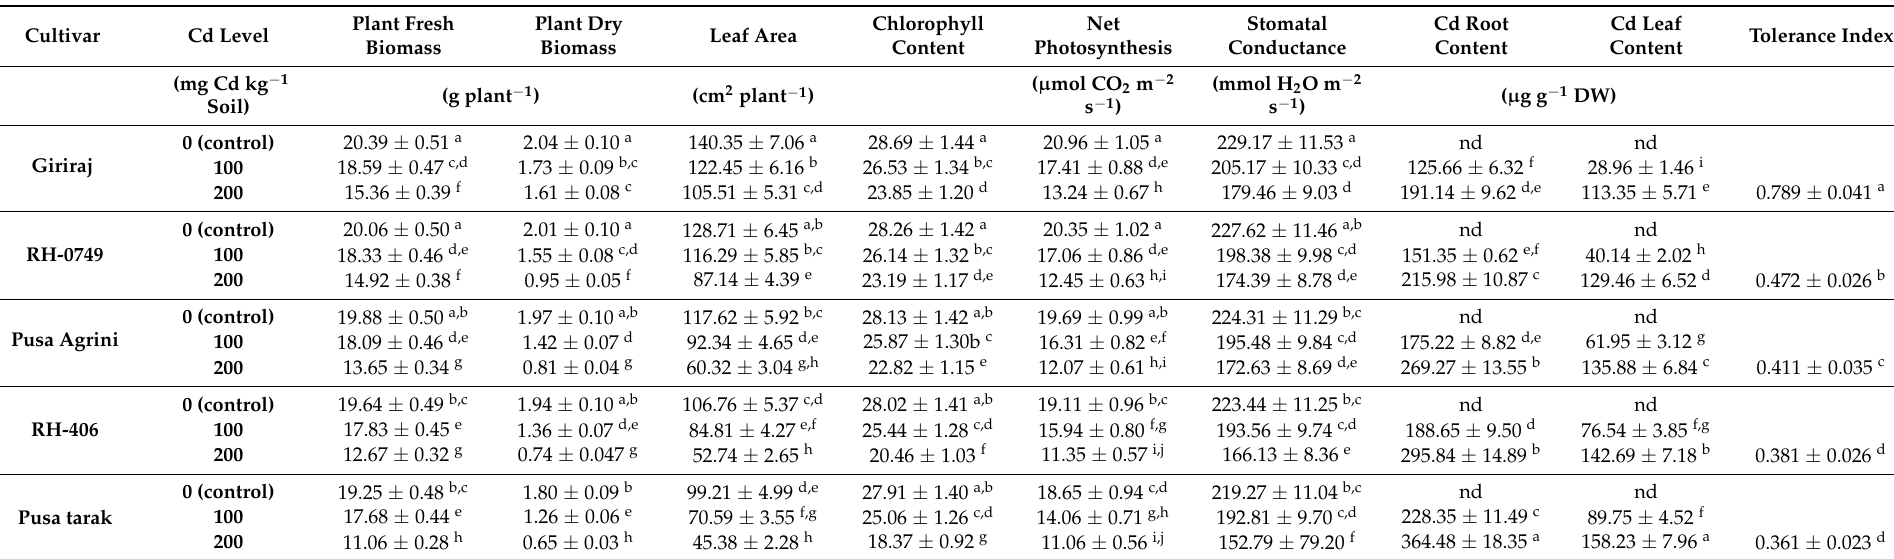
Table 2. Plant fresh biomass, plant dry biomass, chlorophyll content (SPAD values), net photosynthesis, stomatal conductance, intercellular CO 2 , Cd content of roots and leaves, and tolerance index of five Brassica juncea cvs. Giriraj, RH-0749, Pusa Agrani, RH-406, and Pusa Tarak grown under three soil Cd levels [i.e., control 0 Cd (0 mg Cd kg − 1 soil), 100